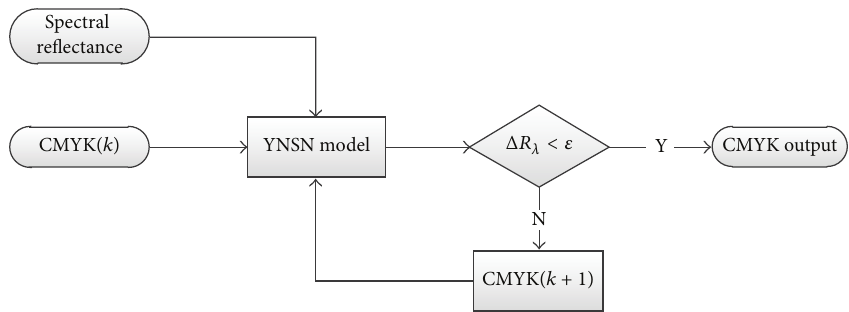
Figure 2: Diagram of spectral separation process based on optimization